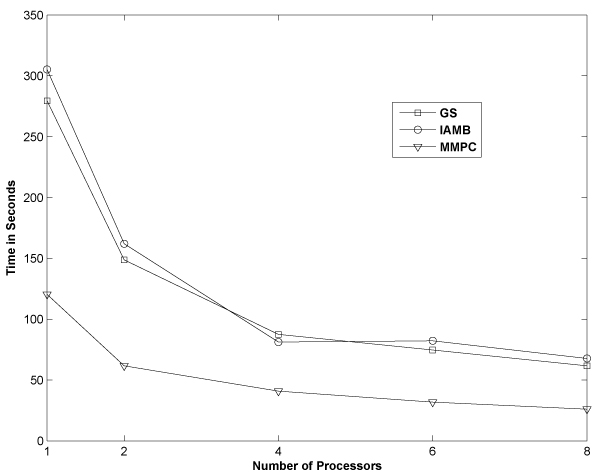
Performance of BSL with bootstrap parallelization. The performance of three BSL techniques (GS, IAMB and MMPC) with increasing number of processors (np = 1, 2, 4, 6 and 8) and 1000 bootstrap simulations, across an 8-processor Linux machine for the data [4]. Each of these algorithms exhibits (~5 fold) decrease in computational time at (np = 8) compared to (np = 1).